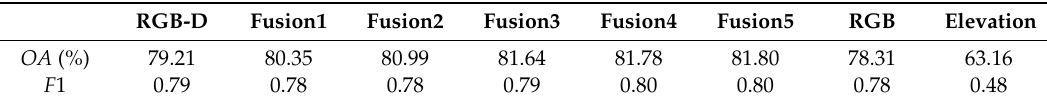
Table 5. Overall Accuracy ( OA ) for dataset Potsdam.